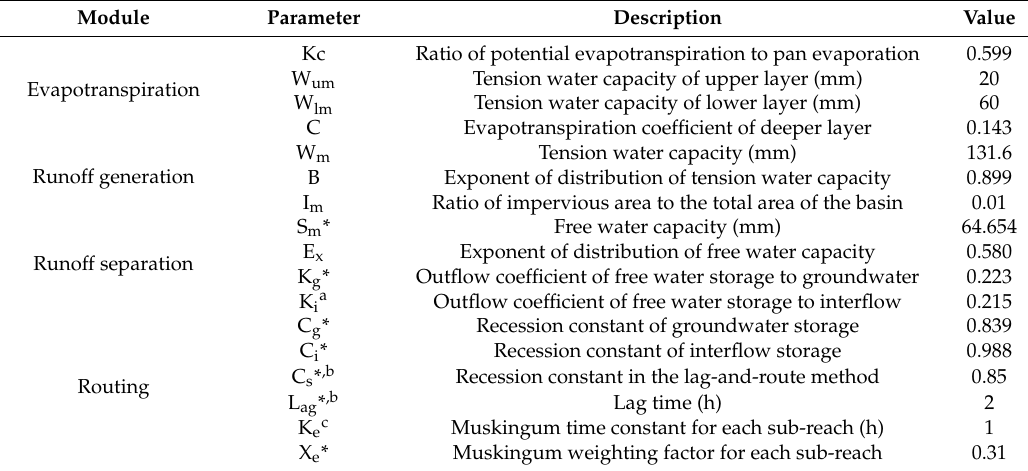
Table 4. The XAJ model Calibrated Paraments and Calibrated Values in Ganjiang River Basin.